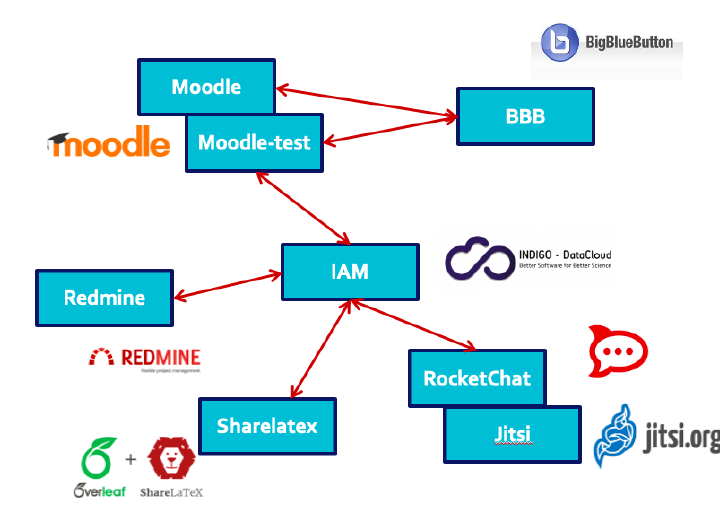
Figure 3. iTHEPHY Platform Building